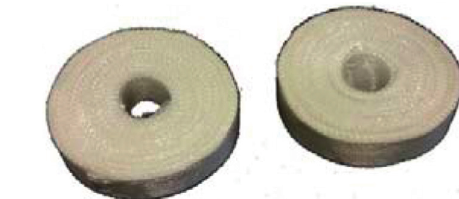
Figure 5: Refractory heat insulation ceramic fiber cloth.